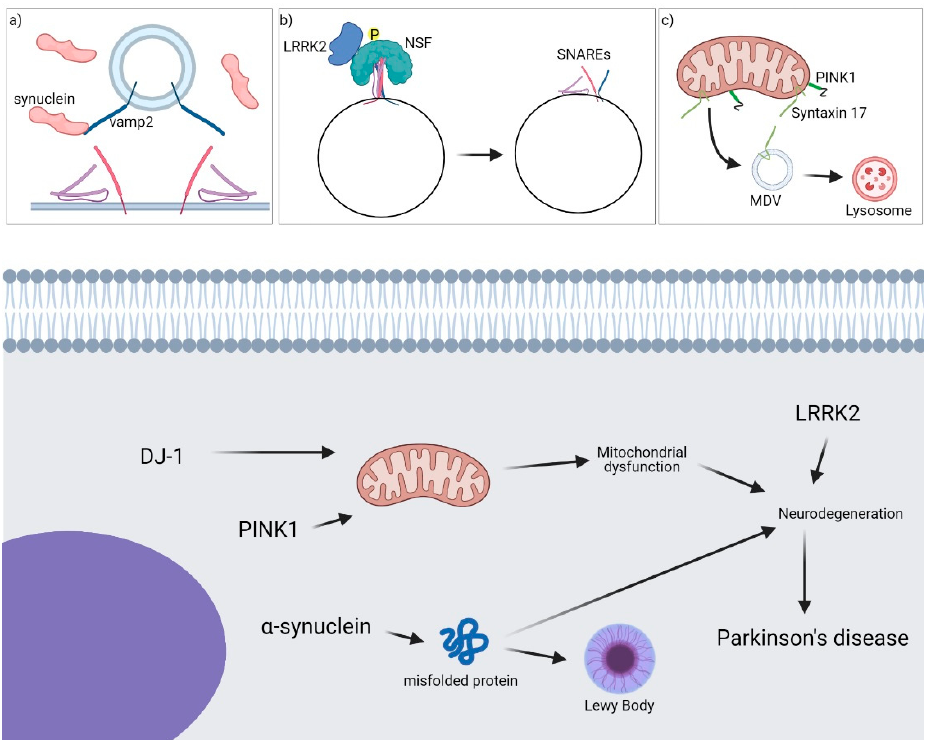
Figure 2. Role of SNARE proteins in PD. A general overview of the main proteins involved in the onset of the pathology is shown. ( a ) α -synuclein binds VAMP2 and inhibits SNARE complex formation at the synaptic site-blocking exocytosis. ( b ) LRRK2 interacts with NSF, phosphorylates it and facilitates SNARE complex disassembly. ( c ) PINK1 and Syntaxin-17 are involved in the formation and fusion of MDVs from mitochondria to endolysosomes/lysosomes.